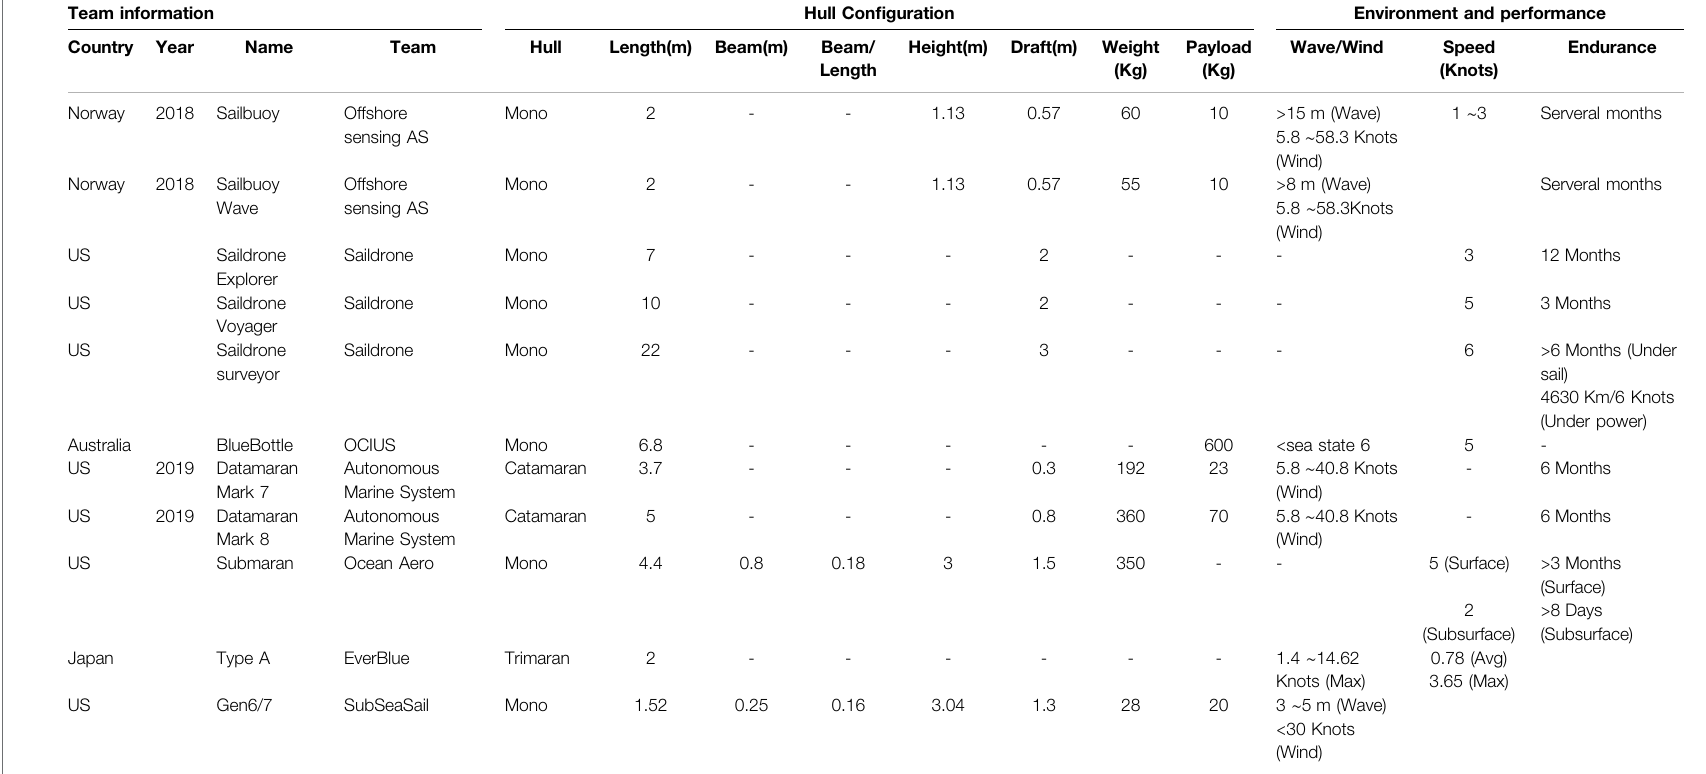
TABLE 3 | The sailboats con fi guration in different companies (Part